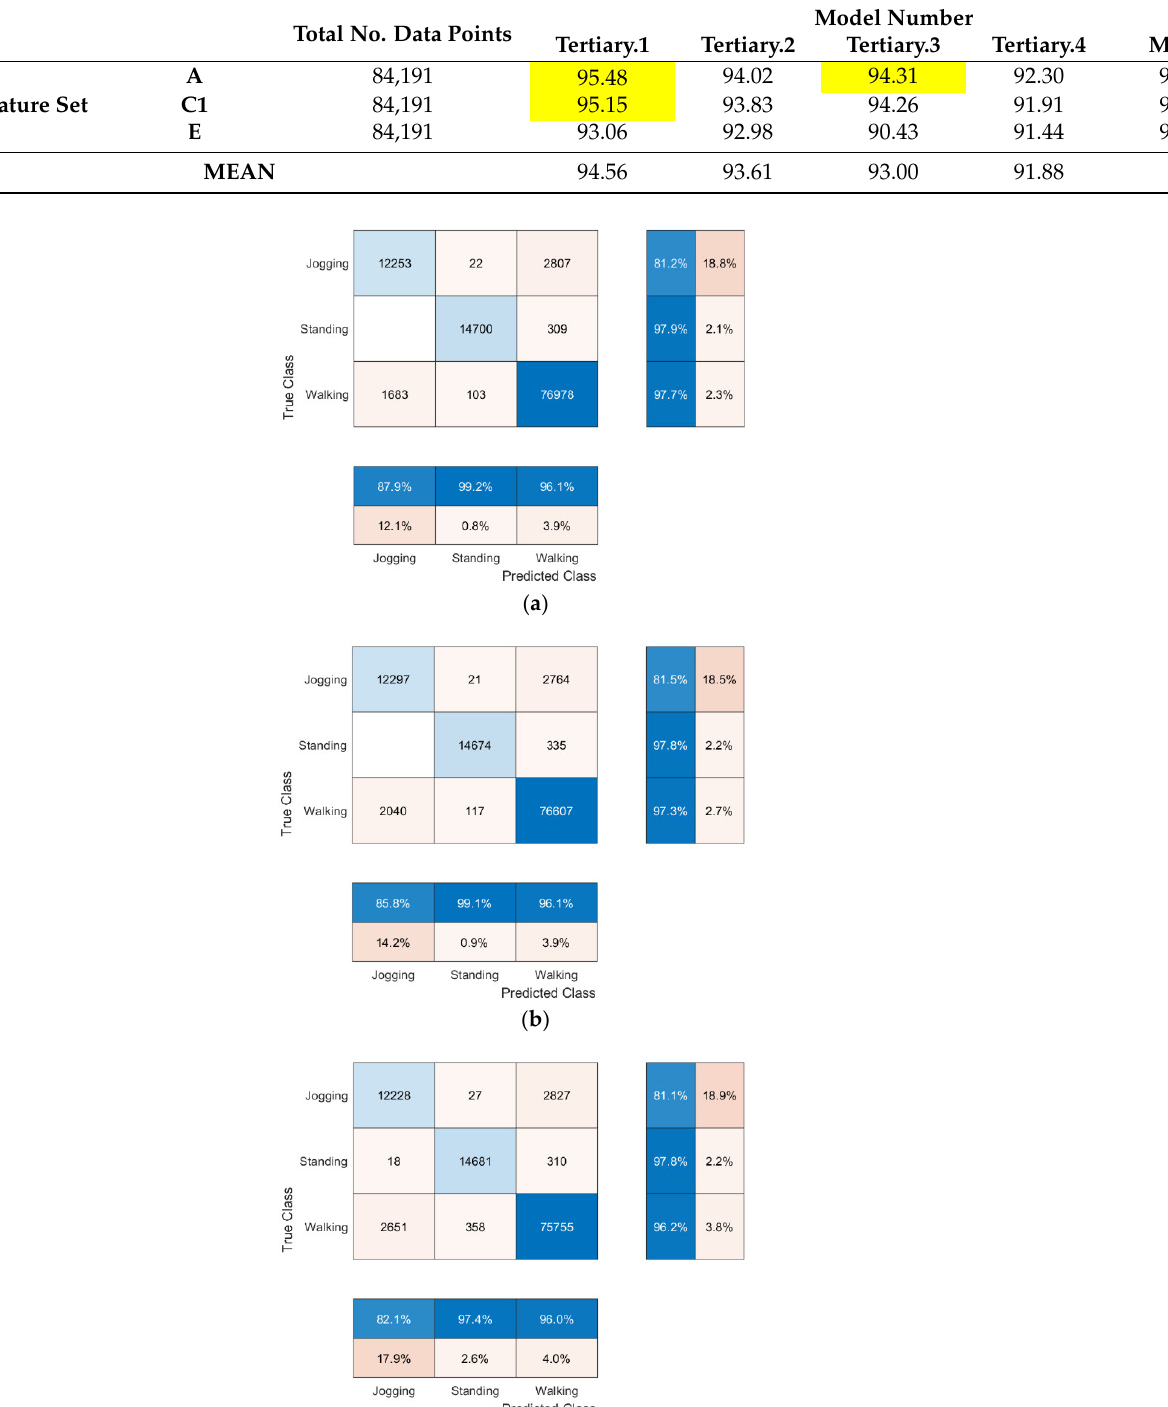
Table 9. A summary of Feature Sets A, E and H paired with each model for the tertiary classification problem, tested using 10-fold cross-validation. The mean percentage accuracy values for each feature set and model number are also shown. The results highlighted in yellow show the top 3 performing models in terms of mean percentage accuracy.